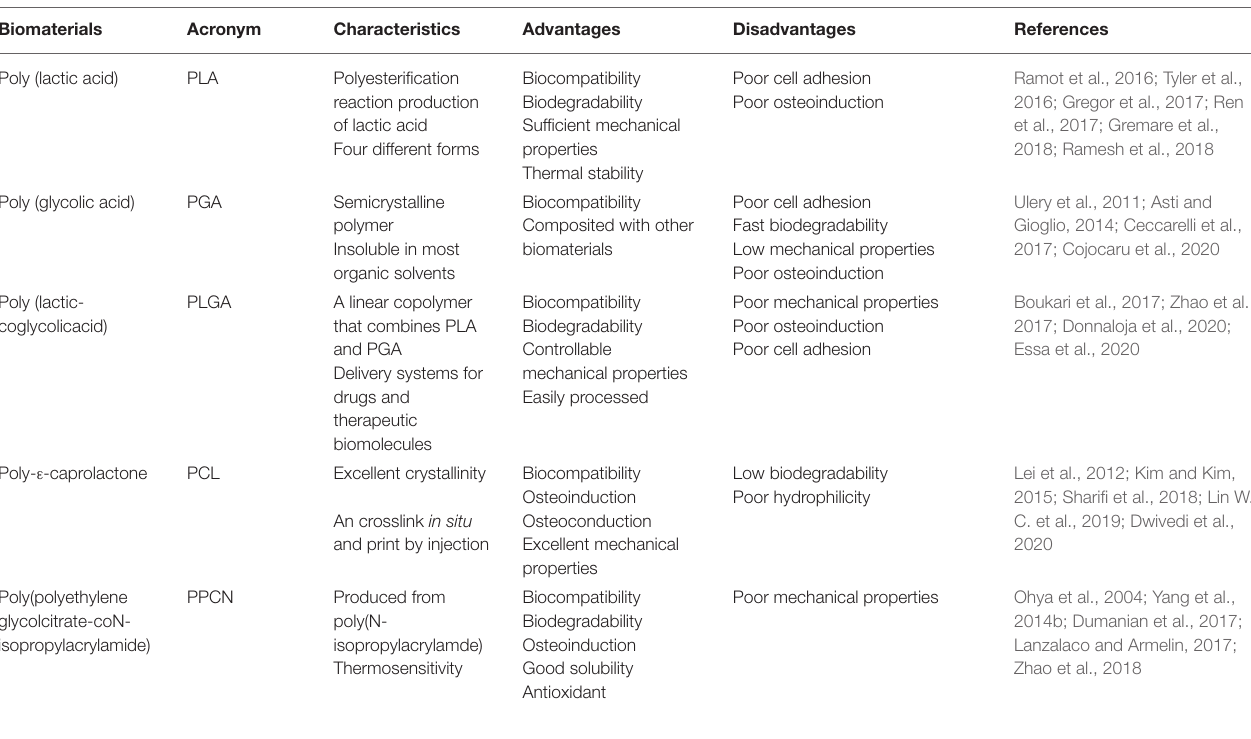
TABLE 3 | Characteristics of various synthetic polymers used in BTE.